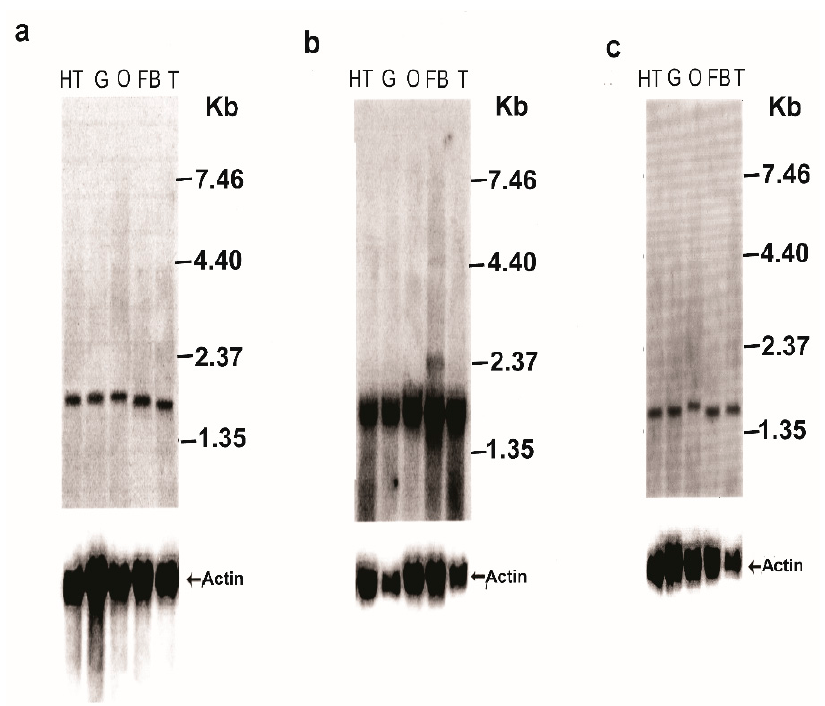
Figure 3. Northern blot analyses of D. melanogaster jheh 1 t ( a ), jheh 2 ( b ) and jheh 3 ( c ) transcripts in the head gut (HT), gut (G), ovary (O), fat body (FB) and total insect extract (T) of female D. melanogaster . Blots were hybridized with specific probes for each transcript (Tables S1–S3). Actin probe was used to show even transfer to the blot. The Northern blot analyses were repeated twice, showing similar